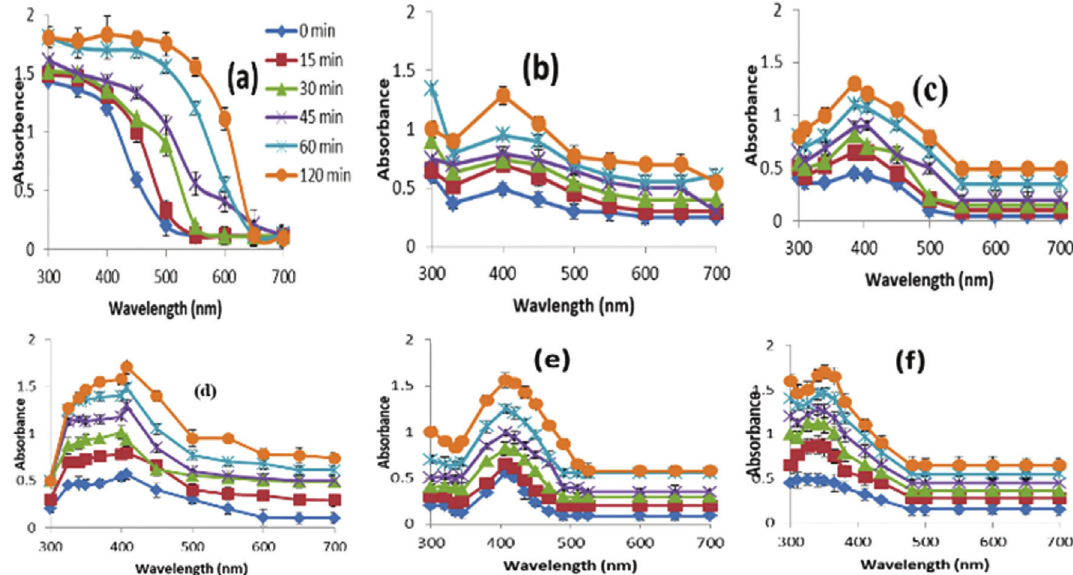
Figure 3: UV-Vis spectrum of Ag NPs synthesized by leaf extract of Diospyros lotus at different pH: (a) pH 4.6, (b) pH 5.6, (c) pH 6.6, (d) pH 7.6, (e) pH 8.6, (f) pH 9.6 recorded at different time intervals (0-120